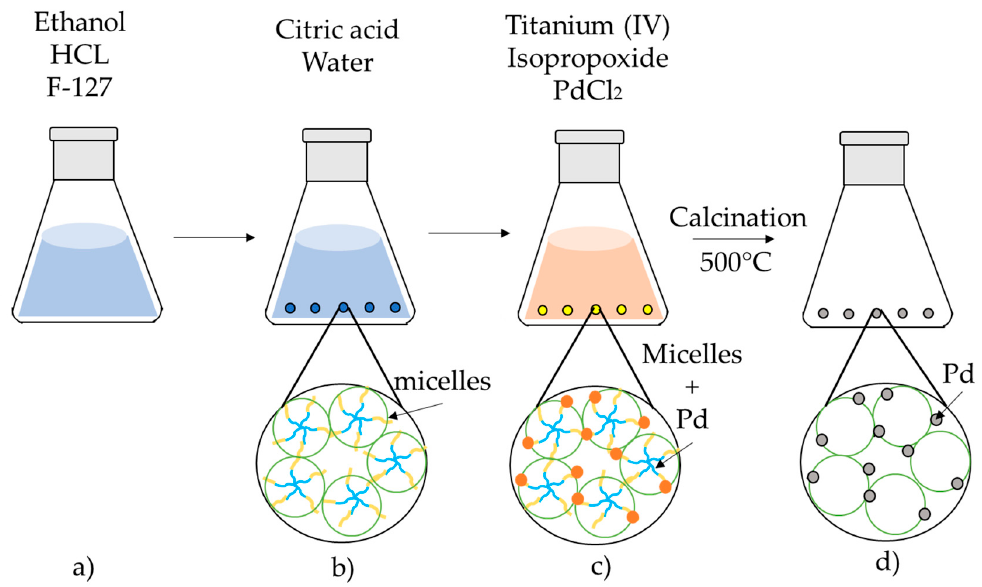
Figure A1. Description of the Four Consecutive Steps during Pd-Doped TiO 2 Photocatalyst Preparation: ( a ) Ethanol enters the interface between the hydrophilic (PEO) and hydrophobic (PPO) chains and attaches to the hydrophobic core, ( b ) Ahydrophobic block (PPO) is placed in a central location surrounded by the PEO tails forming micelles, ( c ) The PEO tails become attached to the TiO 2 , leaving a hybrid outer layer with a dominant TiO 2 composition, and ( d ) Calcination of the resulting photocatalyst precursor yields TiO 2 with a 3D mesoporous structure